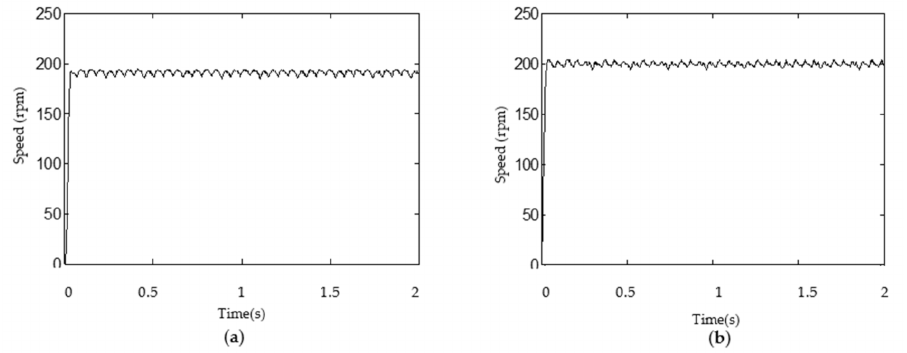
Figure 9. ( a ) The experimental speed response curve of tracking the aim speed 200 rpm under the MFSMC strategy; ( b ) The experimental speed response curve of tracking the aim speed 200 rpm under the proposed MFSTNLSMC